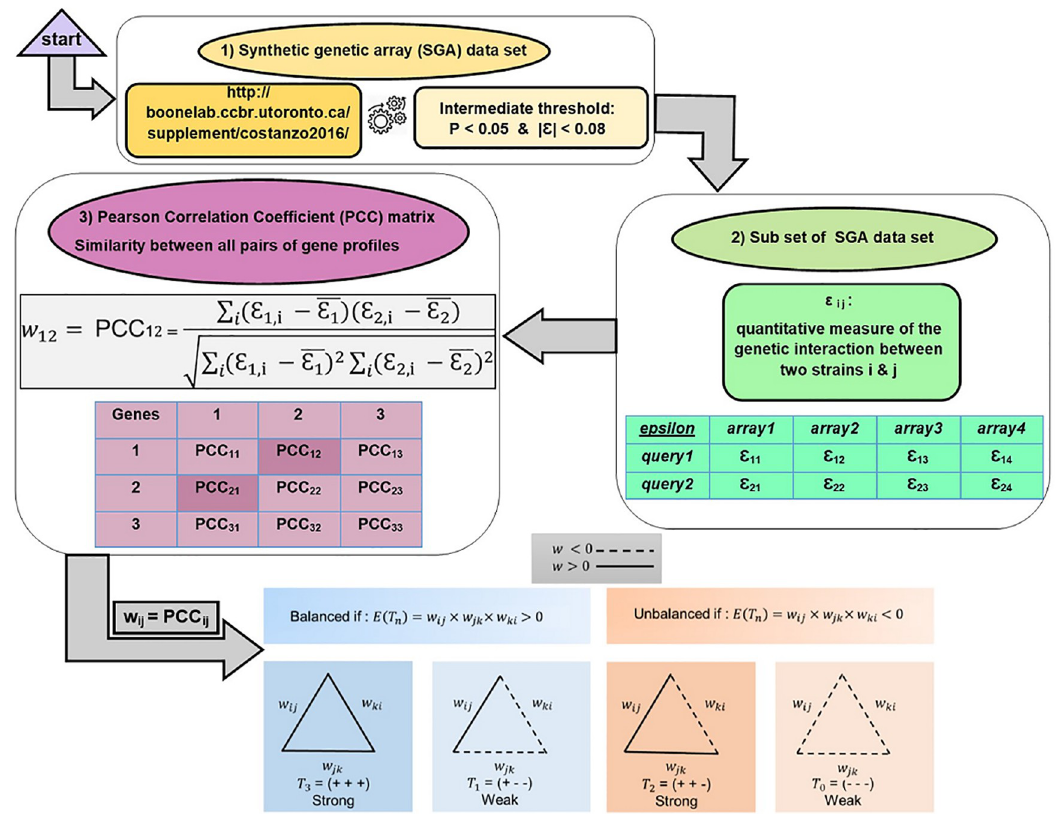
Fig 1. Graphical abstract for the procedure of obtaining the genetic interaction similarity